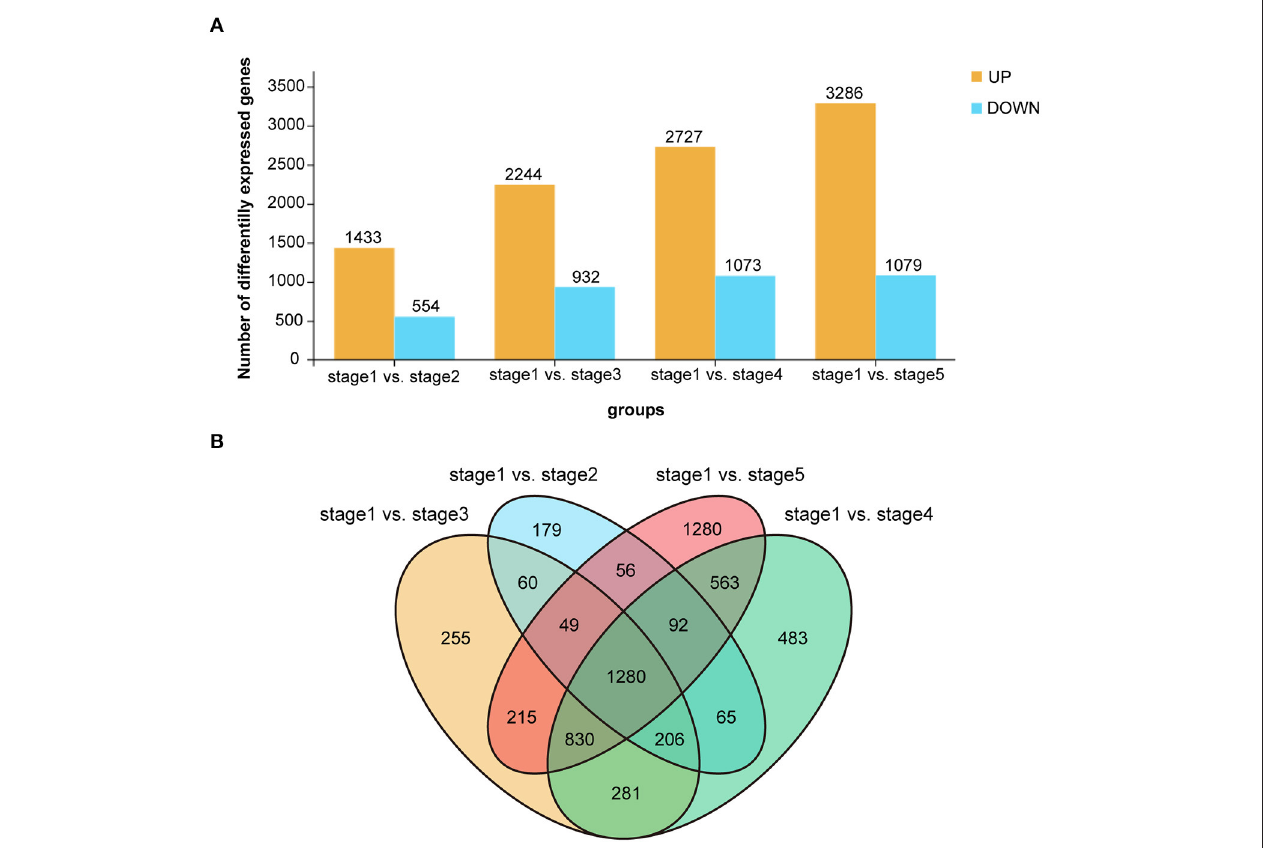
FIGURE 4 | Differentially expressed genes (DEGs) of Madhuca pasquieri (Dubard) H. J. Lam during the post-germination stages. (A) Summary of the number of significantly changed transcripts between successive stages during M. pasquieri post-germination stages. (B) Venn diagram showing the overlap of DEGs during M. pasquieri post-germination